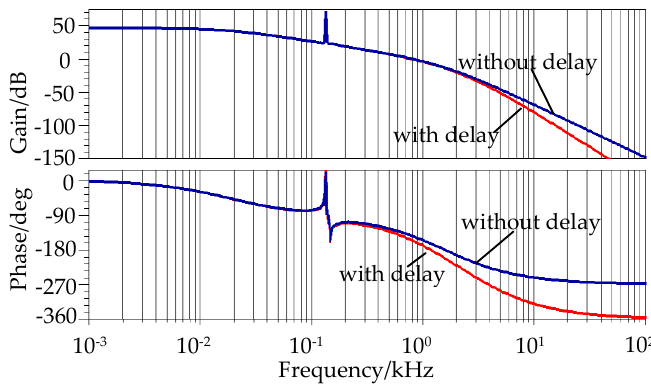
Figure 10. Frequency response influence on current control performance for variation of time delay.